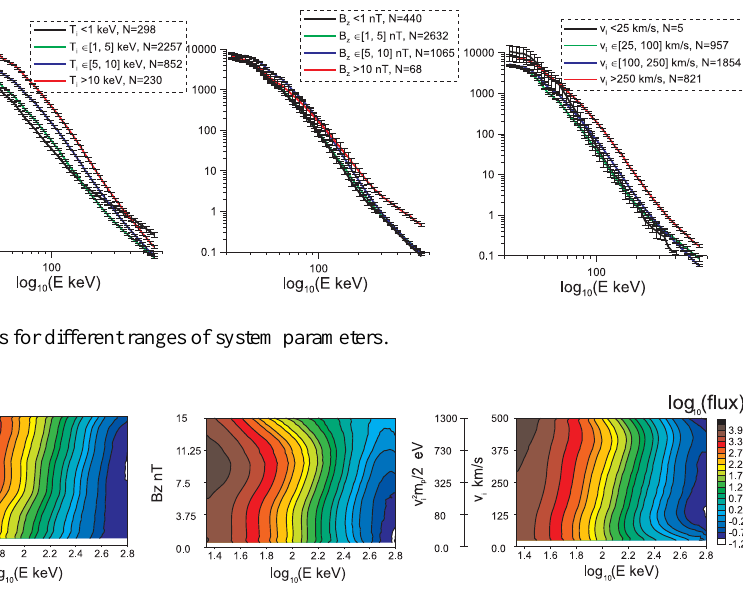
Figure 3. 2-D maps of ion fluxes (measured in (scm 2 srkeV) − 1 ).